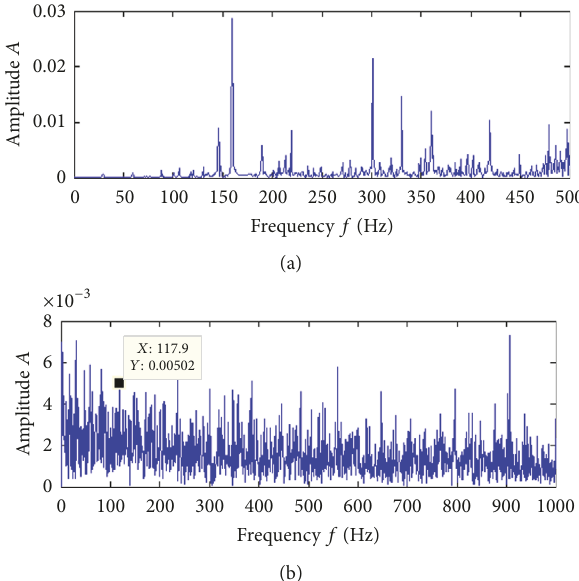
Figure 13: Spectra of slight rolling element fault: (a) local spectrum and (b) envelope